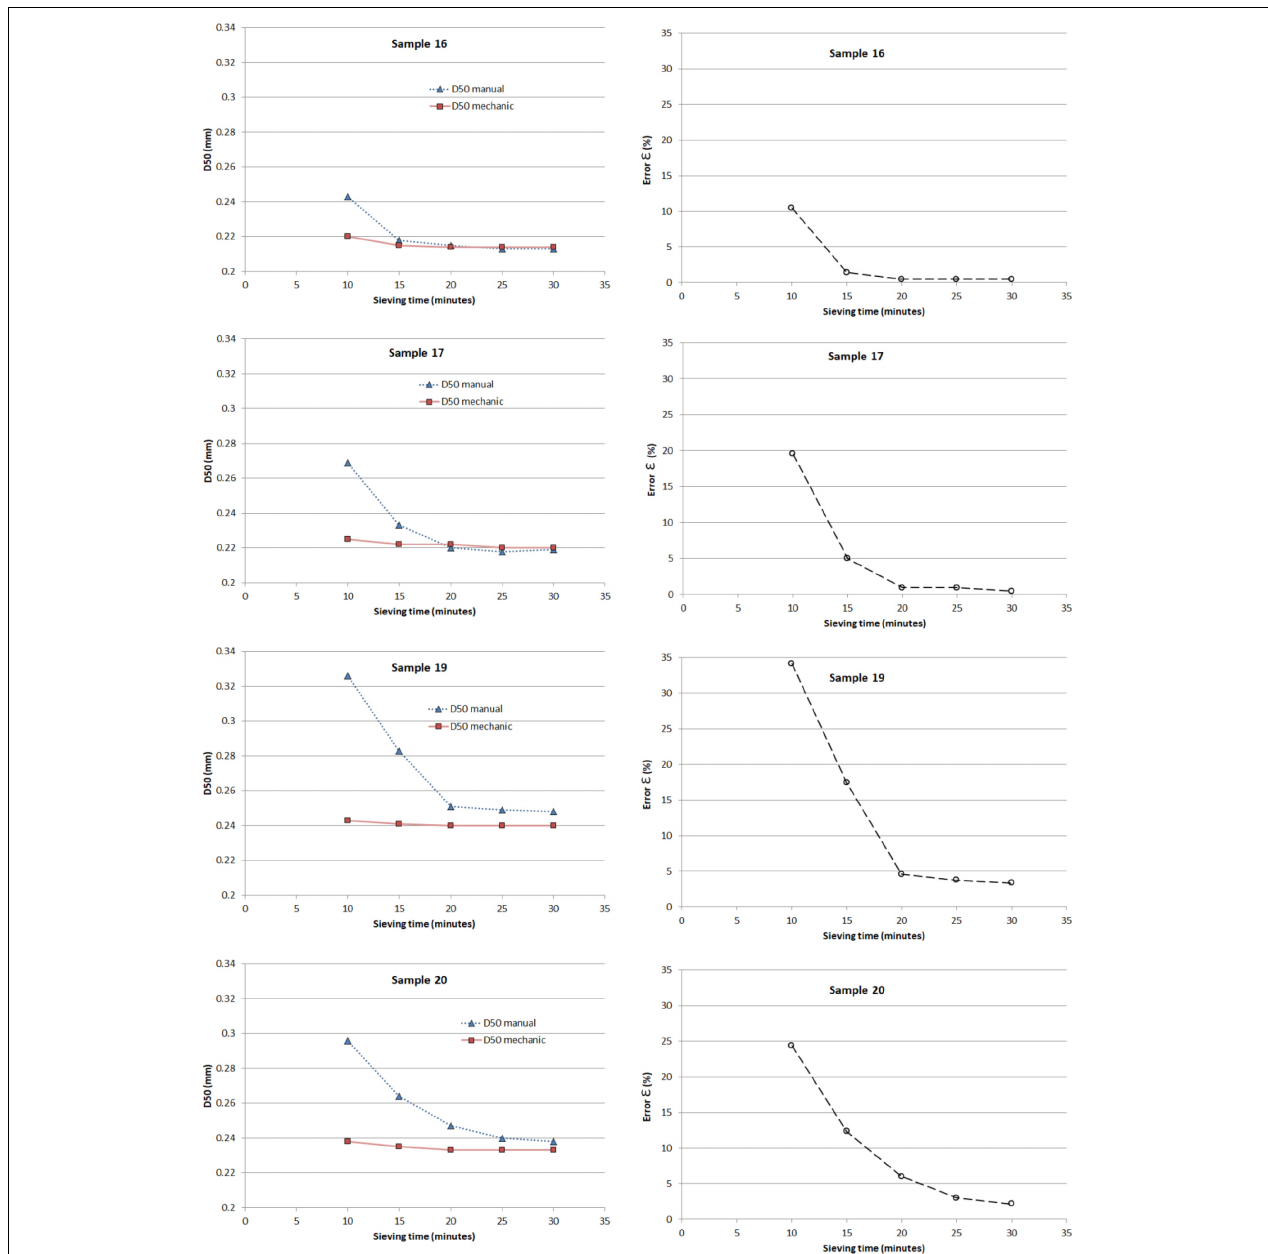
FIGURE 5 | Results of D 50 from samples 16, 17, 19, and 20 sieved during 10, 15, 20, 25, and 30 min, respectively, with mechanical and manual procedures, and their respective errors (%).